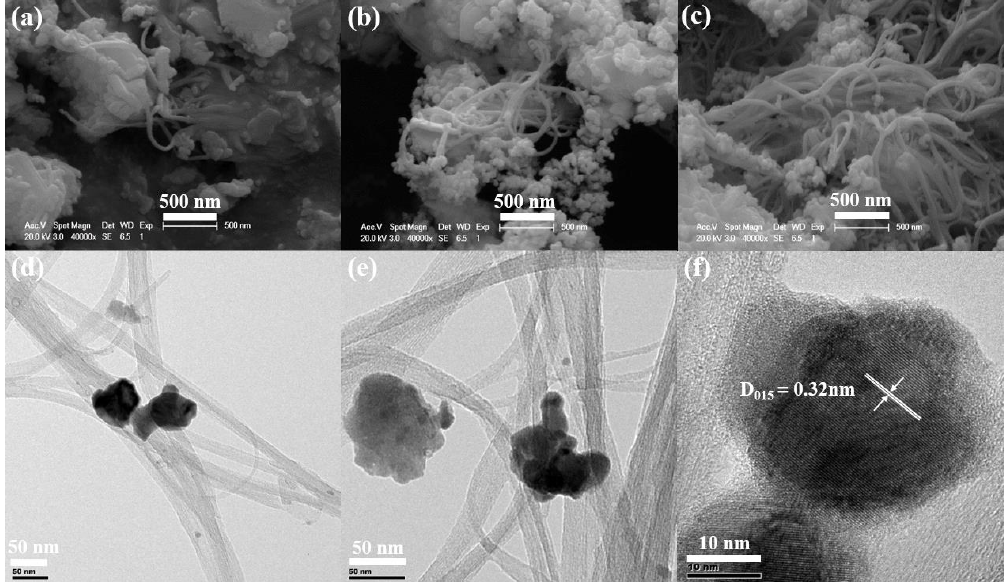
Figure 3. SEM images of the SWCNT / Bi 2 Te 3 composite powders with di ff erent contents of SWCNTs: ( a ) 0.25 wt %, ( b ) 0.5 wt %, and ( c ) 0.75 wt % SWCNTs. TEM images of SWCNT / Bi 2 Te 3 composite powders with di ff erent contents of SWCNTs: ( d ) 0.25 wt %, ( e ) 0.5 wt %, and ( f ) 0.75 wt % SWCNTs.